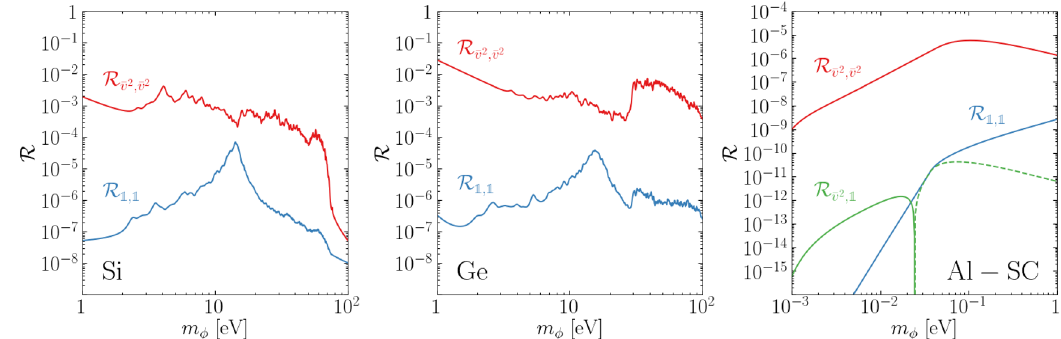
Figure 1 . Comparison between different terms contributing to the scalar DM absorption rate, defined in eq. (3.39), for Si, Ge and Al-SC targets assuming q = 10 − 3 m . Dashed curves indicate φ negative values. In all three targets we see that R dominates over the entire DM mass range ¯ v 2 , ¯ v 2 considered. This term comes from an NLO operator in the NR EFT (underlined in table 1) and cannot be directly related to the target’s optical properties (i.e. the complex conductivity/dielec- tric function). For Si and Ge, the calculation of R is technically challenging as explained in ¯ v 2 , 1 section 4; however, it is parameterically the same order in q as R and therefore expected to be 1 , 1 also subdominant compared to R ¯ v 2 , ¯ v 2